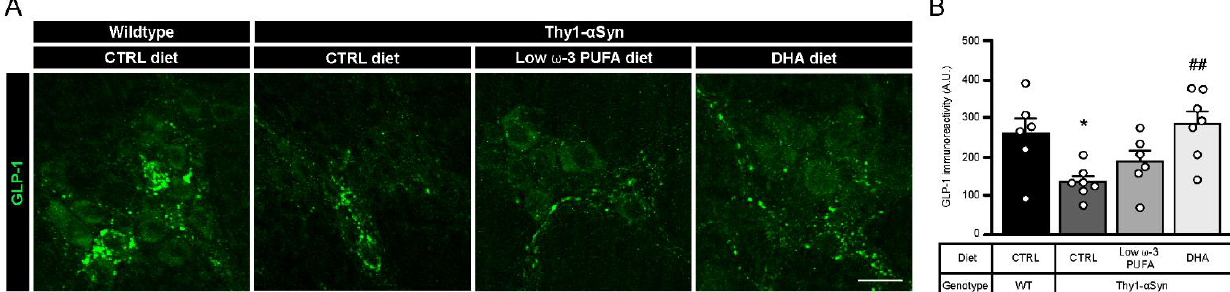
Figure 5. Increase in GLP-1 levels by a high DHA diet. ( A ) Immunofluorescence of GLP-1 in wild-type and Thy1-αSyn mice reveals the presence of the incretin in the myenteric plexus. Scale bar = 60 μm. ( B ) Quantification of the peptide revealed a lower expression in Thy1-αSyn mice compared with wild-type littermates. Transgenic mice fed with DHA-enriched diet show a higher level of GLP-1 than mice fed the control diet (one-way ANOVA: p = 0.0058). Tukey’s post-hoc tests: * p < 0.05 compared with wild-type mice; ## p < 0.01 compared with Thy1-αSyn on control diet. Abbreviations: A.U., arbitrary unit; CTRL, control; DHA, docosahexaenoic acid; GLP-1, glucagon-like peptide-1; WT, wild-type. (white dots) show an increase of varicosities per 100 μm of dendrites in transgenic mice fed with DHA-enriched diet compared to control diet.